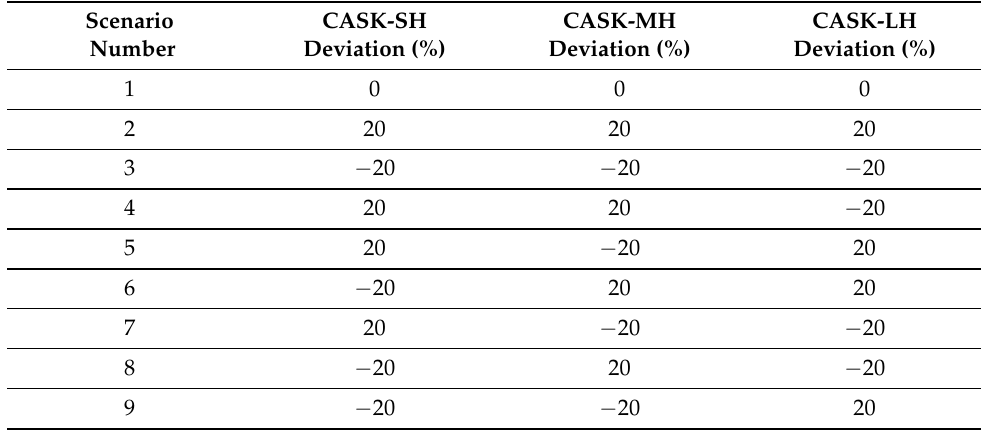
Table 3. Scenarios.